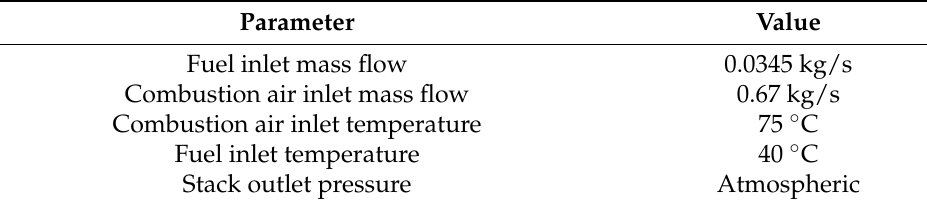
Table 2. Operating conditions of the OTSG.